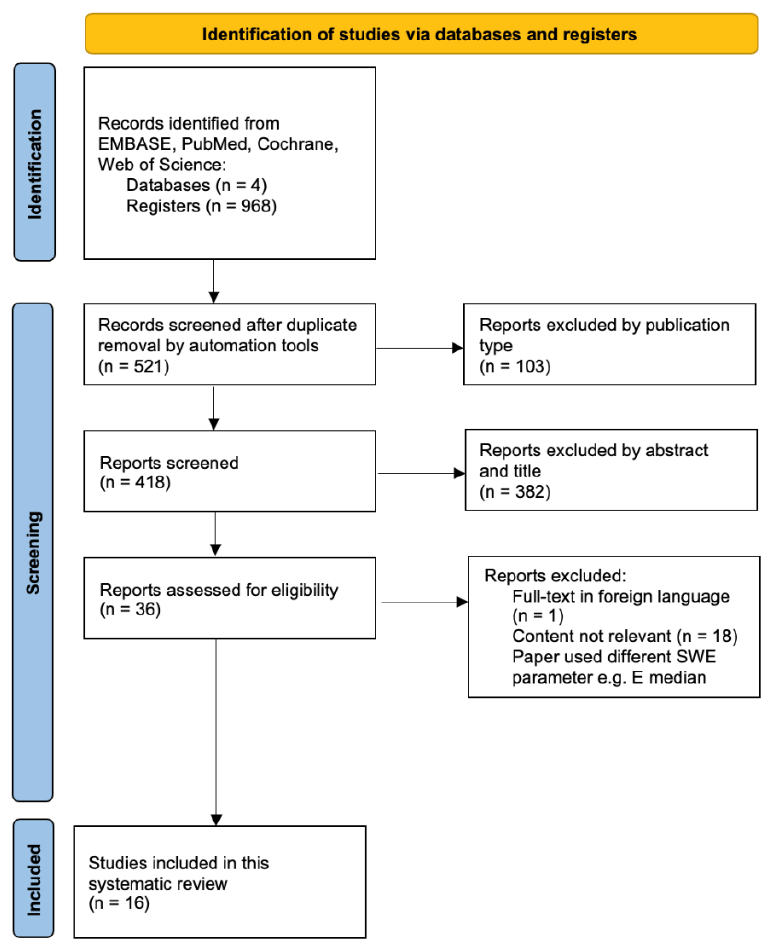
Figure 1. PRISMA flow diagram of evidence acquisition.